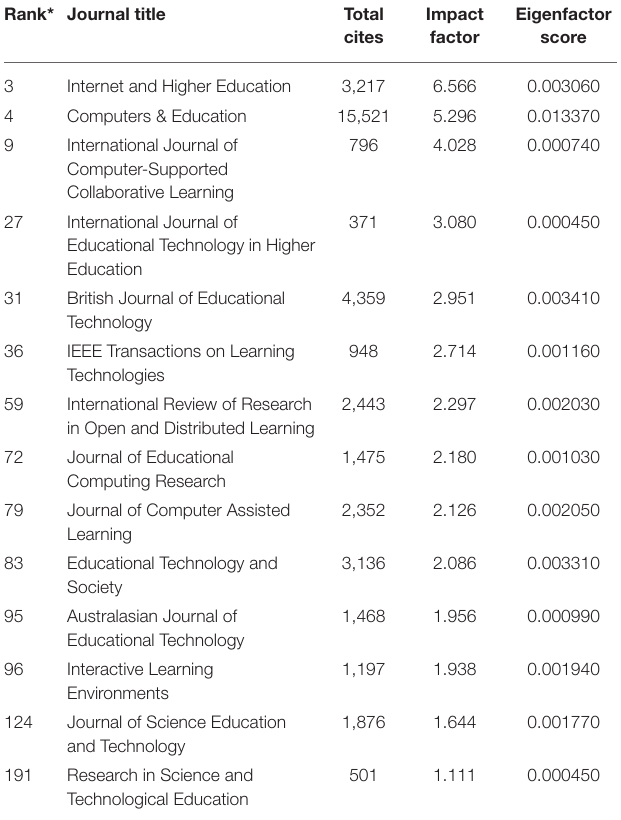
FIGURE 4 | Numbers of the articles published in the educational-technology journals.